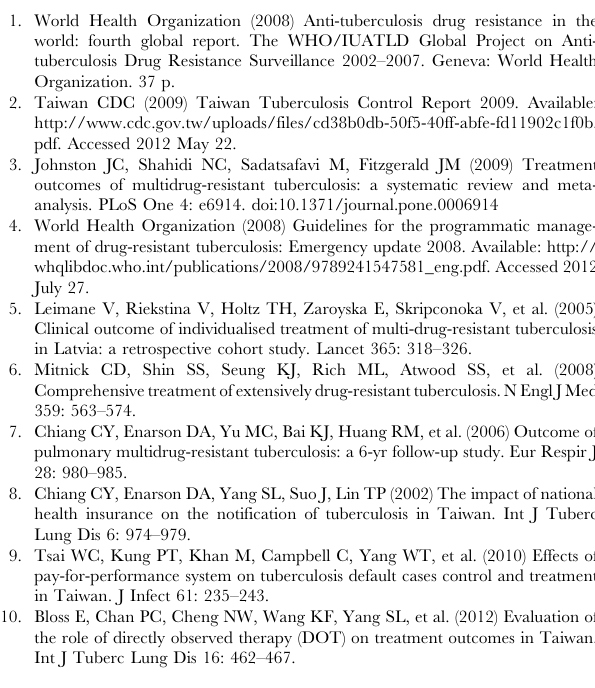
Table S1 The median duration and severity of illness at the time of diagnosis among the various categories of treatment history. Table S2 Basic characteristics of patients with or without second-line anti-TB DST.